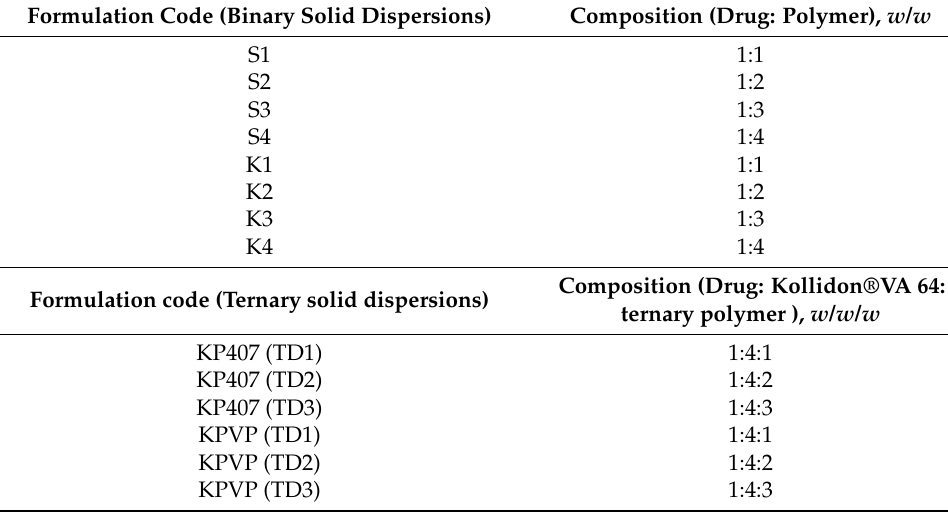
Table 1. Composition of binary and ternary solid dispersions. Formulation Code (Binary Solid Dispersions)